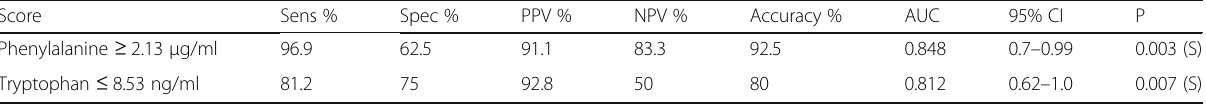
Table 4 ROC curve for the performance of amino acids in the prediction of very severe depression among the treated cases Score Sens %